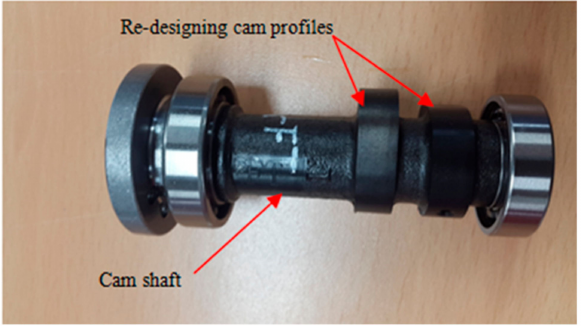
Figure 14. The new camshaft.